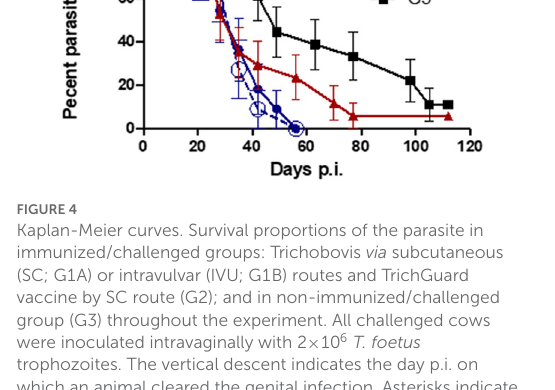
( P > 0.05, two-way ANOVA-Bonferroni post-test).